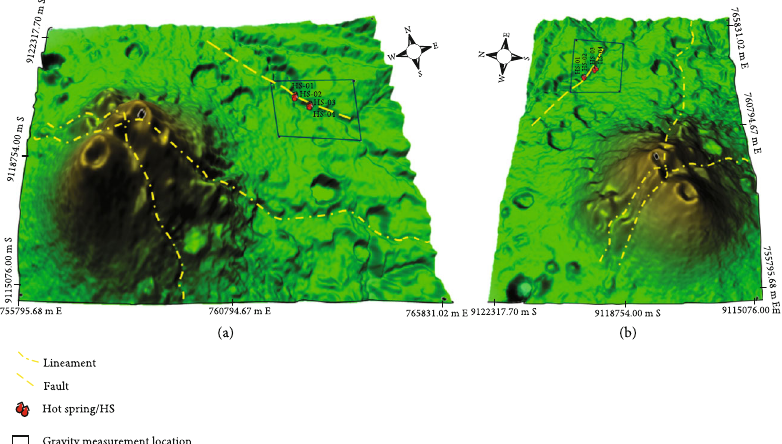
Figure 9: 3D visualization of DEM SRTM data. (a) 3D view of the research location from the south. (b) 3D view of the research location from the